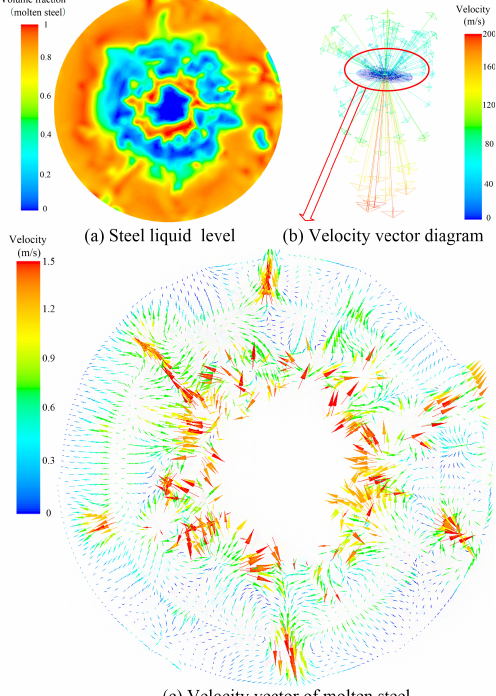
Figure 9. Velocity vector diagrams of molten steel at the steel liquid level. ( a ) Volume fraction of molten steel at the steel liquid level. ( b ) Velocity vector diagram of gas–liquid interface. ( c ) Velocity vector diagram of molten steel.